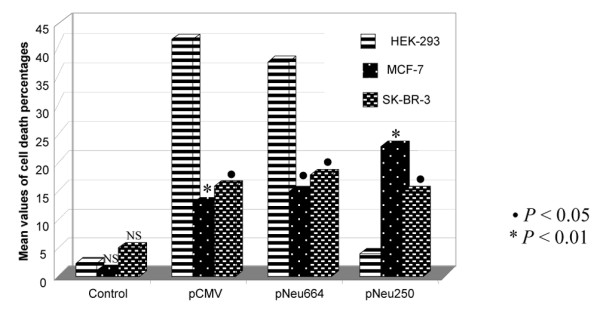
Cytotoxicity assays on HEK-293, MCF-7 and SK-BR-3 cells stably transfected or not with CMV promoter (pCMV)/murine α1,3galactosyltransferase (mαGalT), pNeu664/m αGalT, or pNeu250/mαGalT. Cells were distributed in 96-well plates (5.104/well) and incubated with human sera, after which rabbit complement was added. Cell death was analyzed using an XTT reagent proliferation assay. Results (means of triplicates) are expressed as percentages of cell death, relative to the amount of formazan formation (absorbance evaluated at 490 nm; NS, not significant).